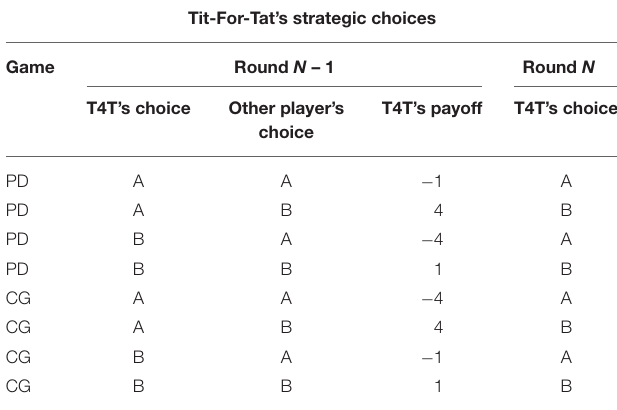
TABLE 1 | Choices that the Tit-For-Tat (T4T) strategy would make on round N during both Prisoner’s Dilemma (PD) and Chicken Game (CG) based on the previous choice (round N – 1) of both the strategy and other